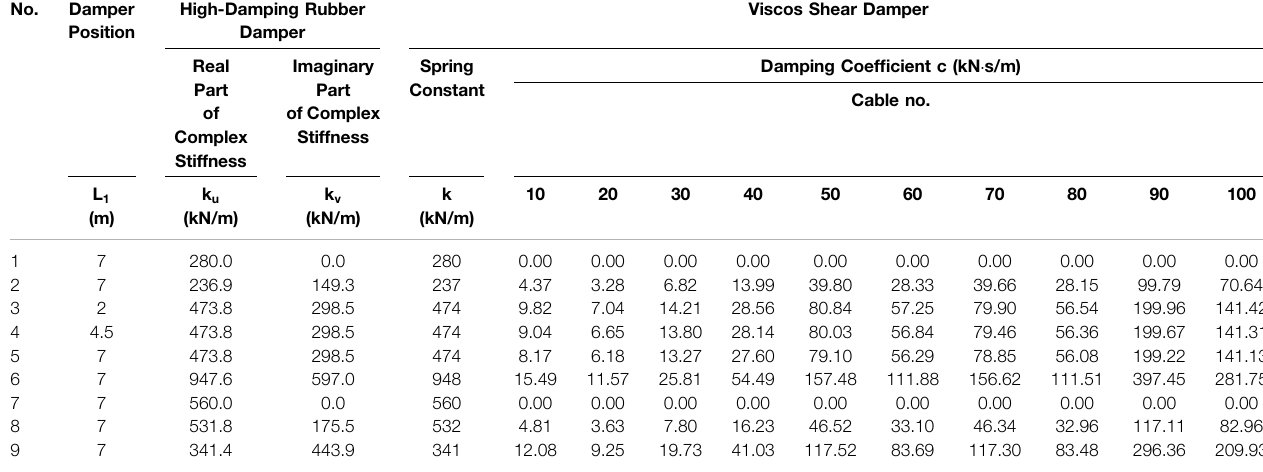
TABLE 2 | Damper parameters in numerical veri fi cation. No.